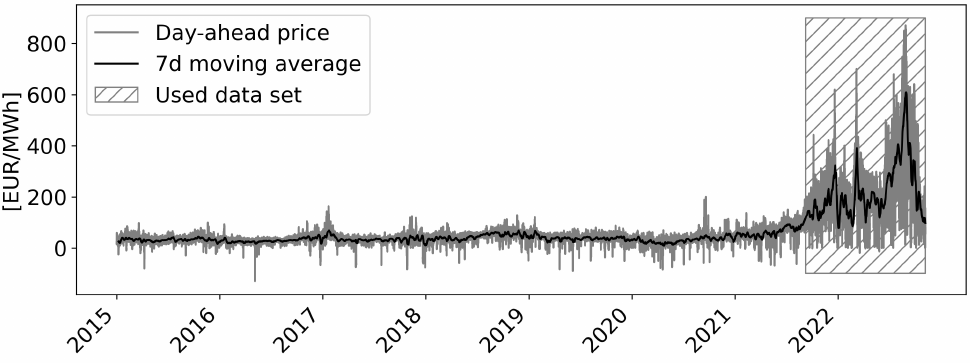
Figure 1. History of day-ahead electricity prices on the German spot market (grey: hourly prices on the European Energy Exchange (EEX), black: 7-day moving average), hatched area: data set used for experiments